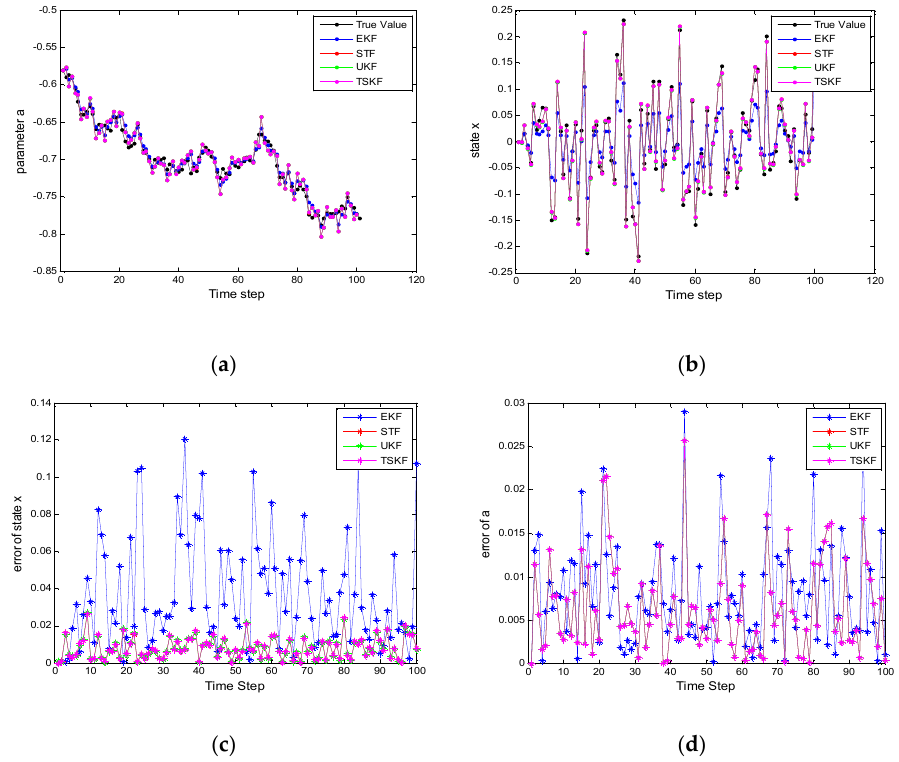
Figure 1. Filtering effect on parameter α and state x : ( a ) true value and estimated value of α , ( b ) true value and estimated value of x , ( c ) estimation error of α and ( d ) estimation error of x Table 2. Performance comparison of different algorithms.